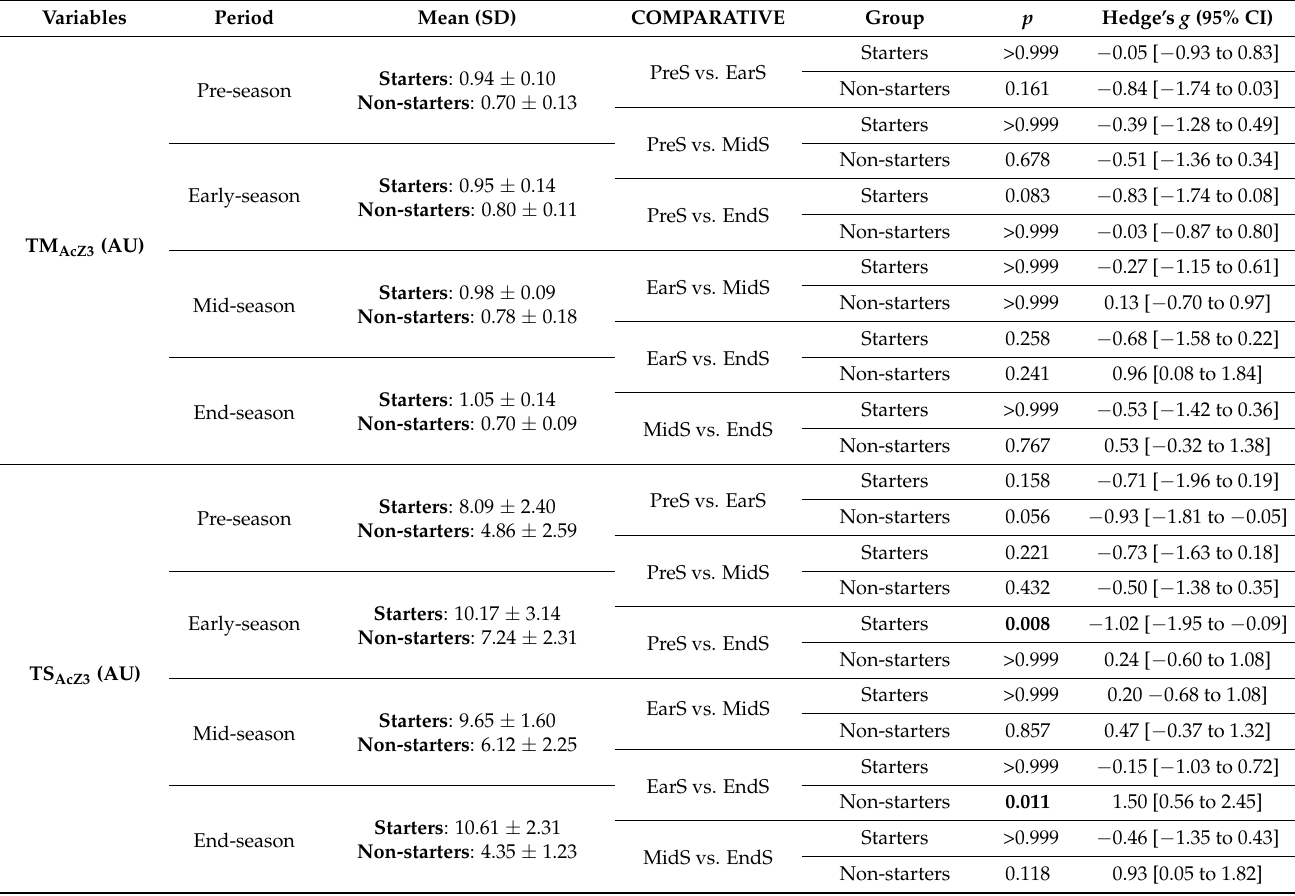
Table 3. Intragroup differences for binary comparisons between season periods in TM and TS in AcZ3 for both non- and starter players.